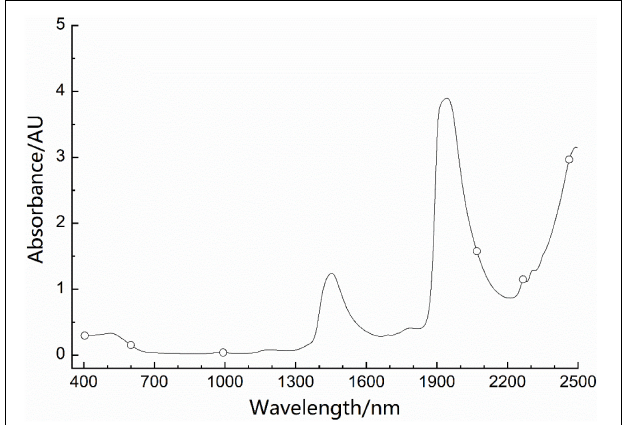
FIGURE 4 | Position of the wavelength combination of the optimal equidistant combination (EC)-wavelength step-by-step phase-out (WSP)-Bayes model labeled in the average spectrum.